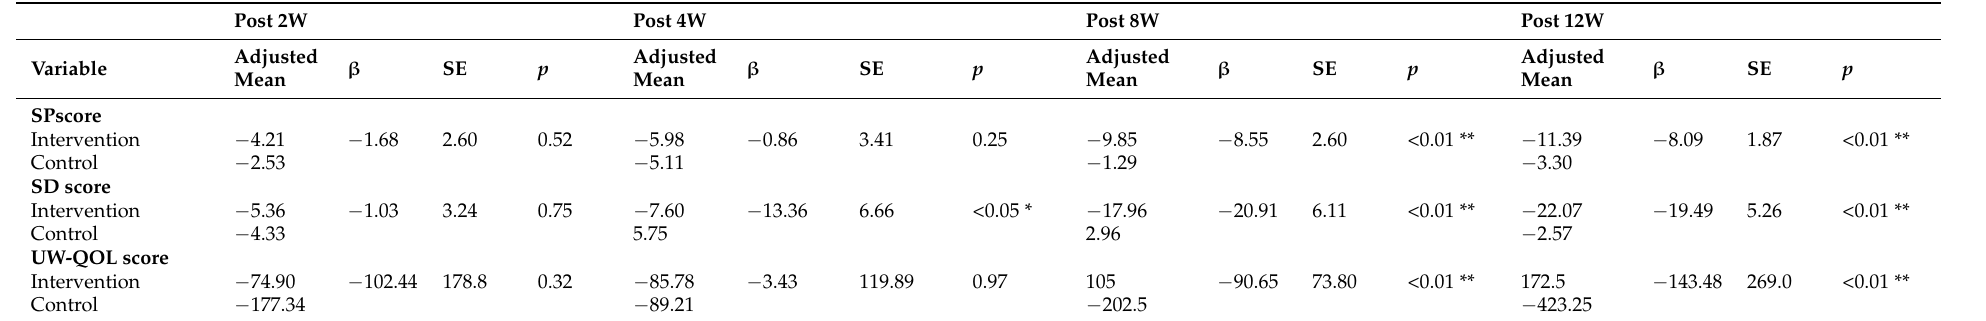
Table 3. ANCOVA analyses of changes in the adjusted mean scores for shoulder pain, shoulder disability, and UW-QOL at different timepoints after surgery ( n =